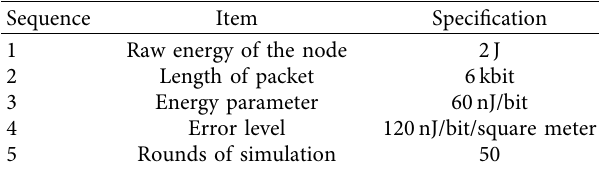
Table 3: Test conditions of energy